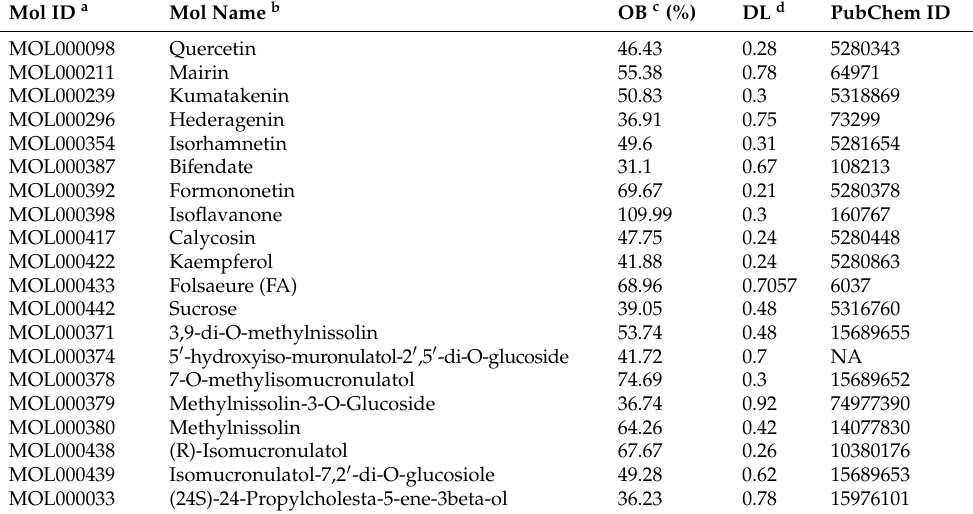
Table 2. The active components in